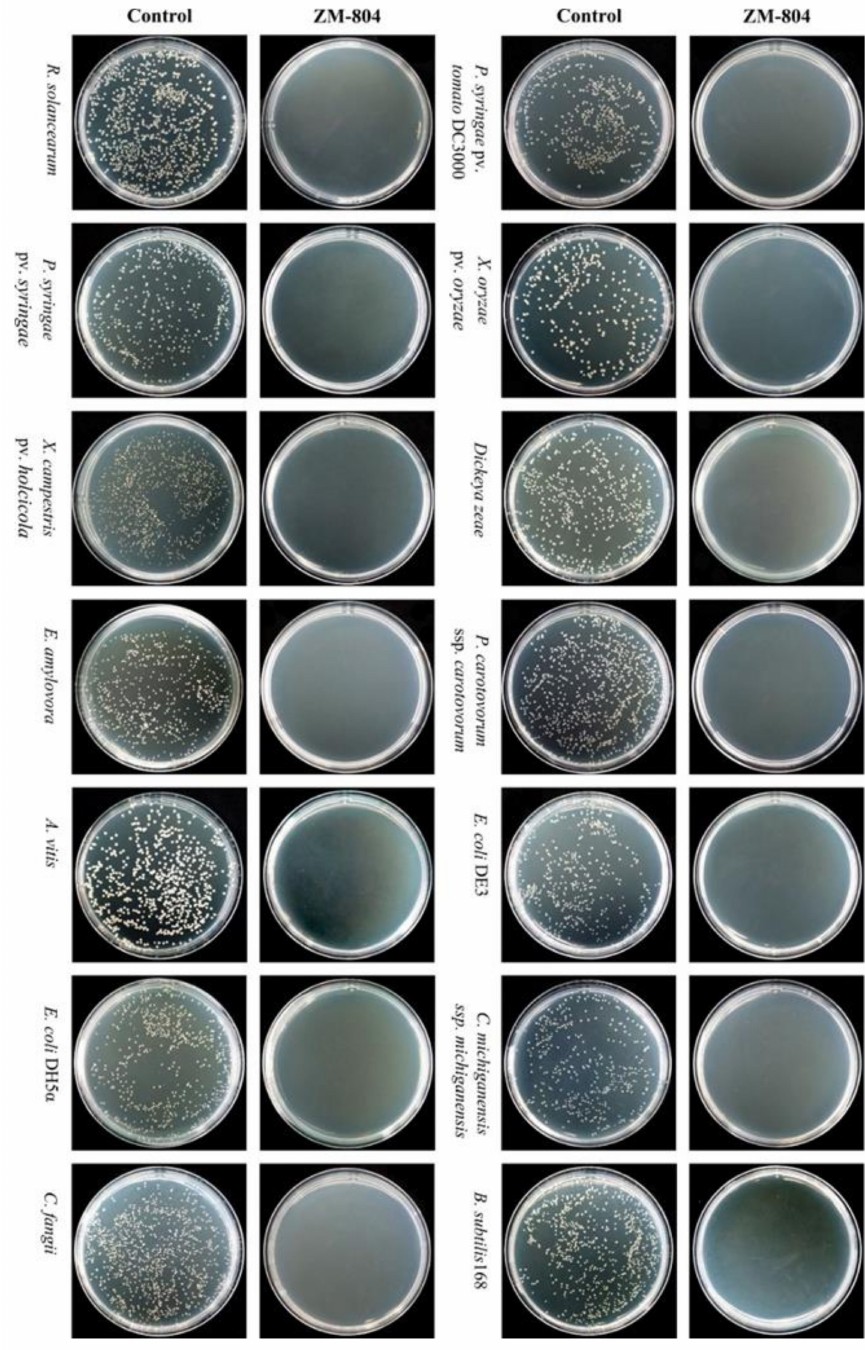
Figure 2. The MLC of the ZM-804 peptide. No bacterial growth was observed after treatment with 4 µ M ZM-804 peptide for all bacterial indicators (Gram-positive and Gram-negative). In contrast, bacterial indicators have grown normally on the control plates (treated with dd